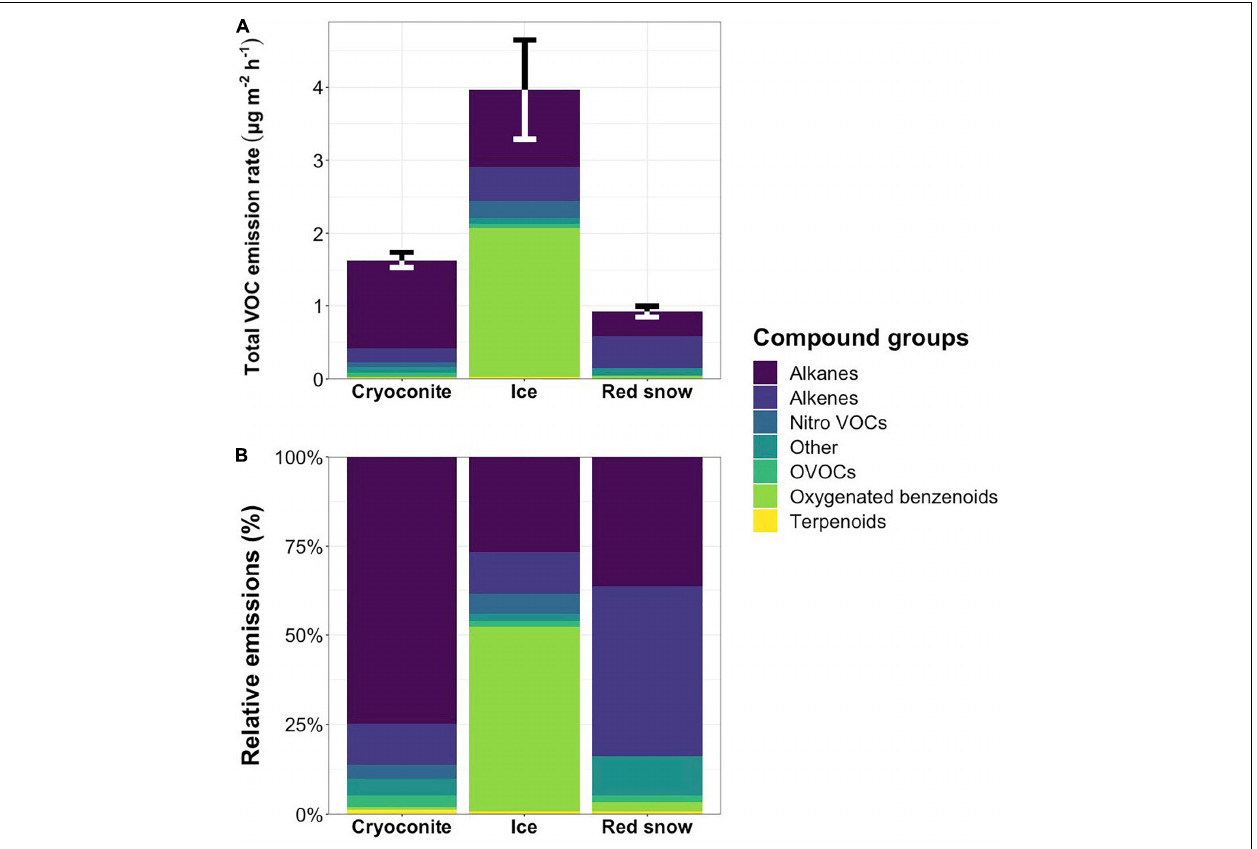
FIGURE 4 | Mean total emission rates in µ g m − 2 h − 1 (A) with error bars representing the standard error for total VOC emissions and mean relative emissions (B) per compound class from cryoconite holes, bare ice surfaces and red snow. Percentages per compound class, including standard errors, are presented in Supplementary Table 2